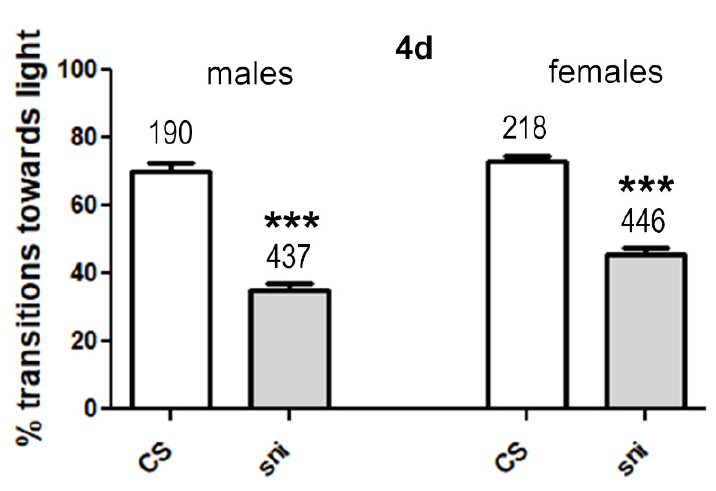
Figure 2. Percentage transitions towards light for sniffer ( sni ) and Canton S (CS) flies. Drosophila melanogaster sniffer mutants and CS flies were fed standard food for 4 days. Fast phototaxis was then performed with groups of 10–20 flies separated by genotype and sex. The number of flies tested is indicated above the bars. Error bars represent SEMs *** = p < 0.001.